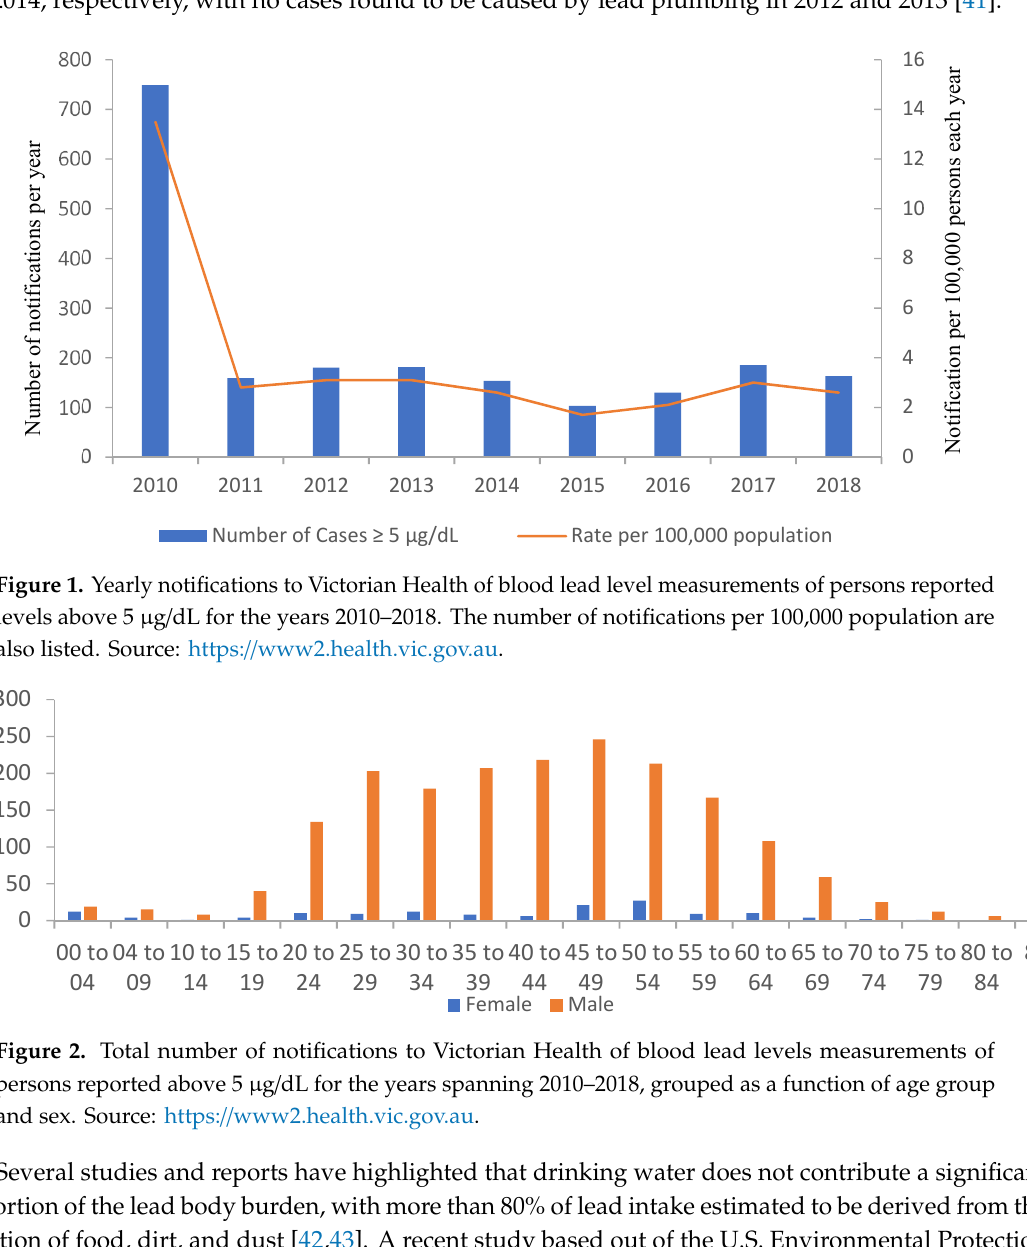
Figure 2. Total number of notifications to Victorian Health of blood lead levels measurements of persons reported above 5 µg/dL for the years spanning 2010–2018, grouped as a function of age group and sex. Source: https://www2.health.vic.gov.au.